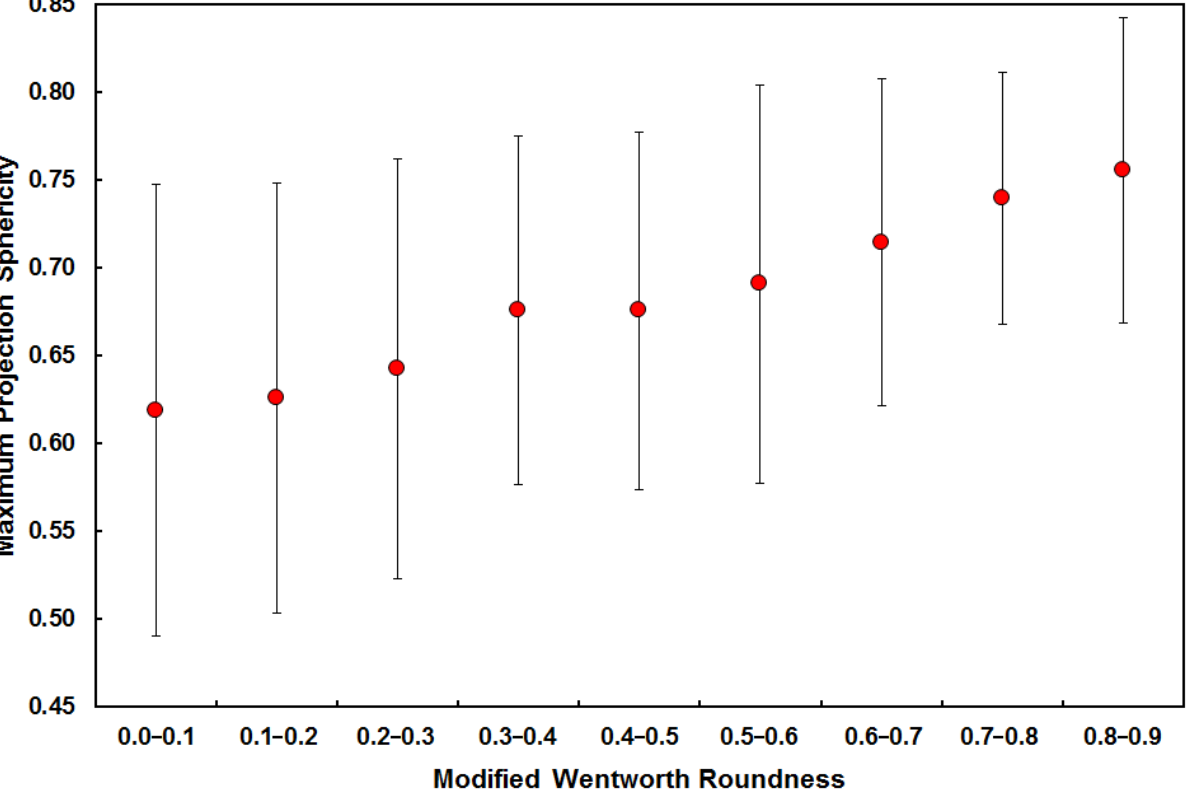
Figure 12. The Maximum Projection Sphericity of fluvial gravels of Navilawa Monzonite from Stations 1–7 along the Sabeto River of western Viti Levu, Fiji as a function of their Modified Wentworth Roundness. The data points are expressed with an uncertainty of ±1 s .